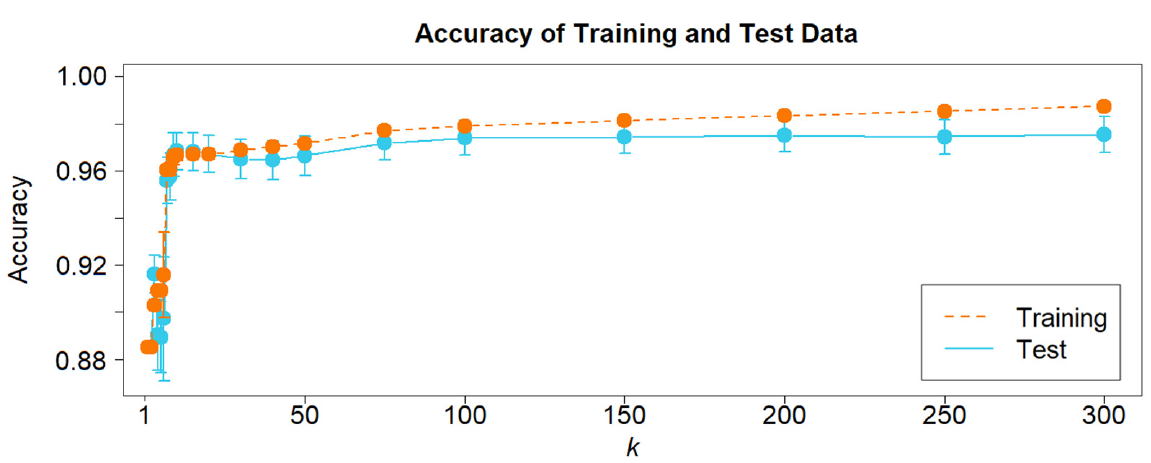
Figure 3. Comparison of classification accuracy in training and test data with increasing k . The error bars show the standard deviation of accuracy across all folds. One hundred calculations (ten folds with ten repetitions) were performed for each cluster using the demo item (more in Section 2.6.1).